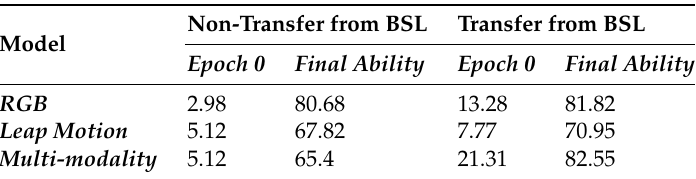
Table 8. Results of pre-training and classification abilities of ASL models, with and without weight transfer from the BSL